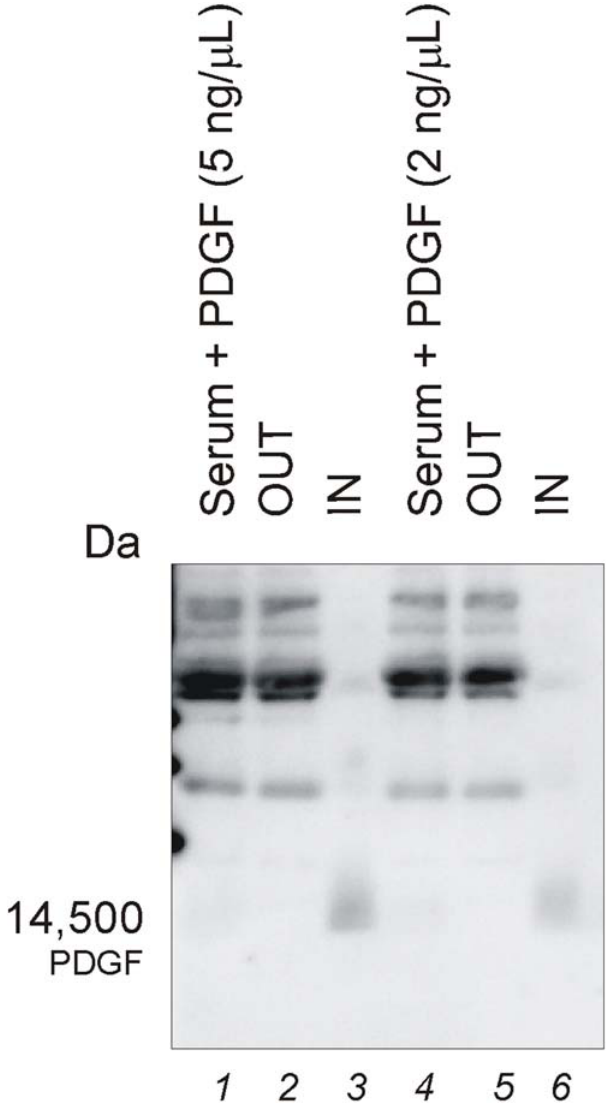
Figure 11. Immunoblot analysis demonstrating recovery of PDGF spiked in human serum. Lane 1) Human serum plus PDGF (5 ng/ m L): when serum is not incubated with particles, PDGF cannot be detected; 2) particle supernatant (OUT); 3) particle content (IN); 4) Human serum plus PDGF (2 ng/ m L): when serum is not incubated with particles, PDGF cannot be detected; 2) particle supernatant (OUT); 3) particle content (IN).